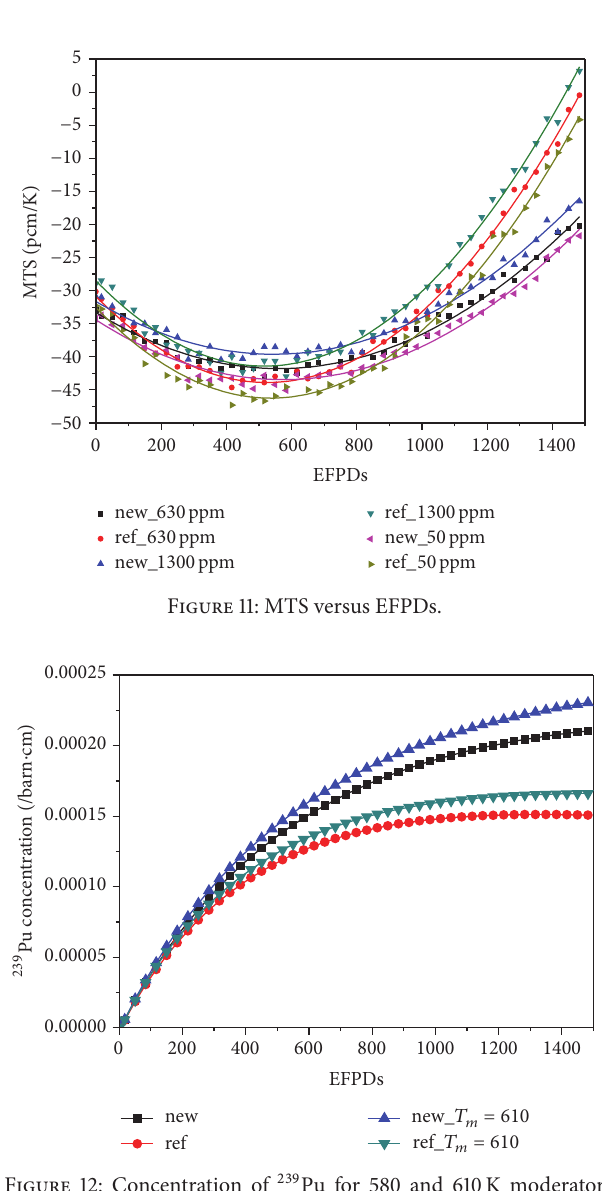
Figure 12: Concentration of 239 Pu for 580 and 610K moderator temperature.